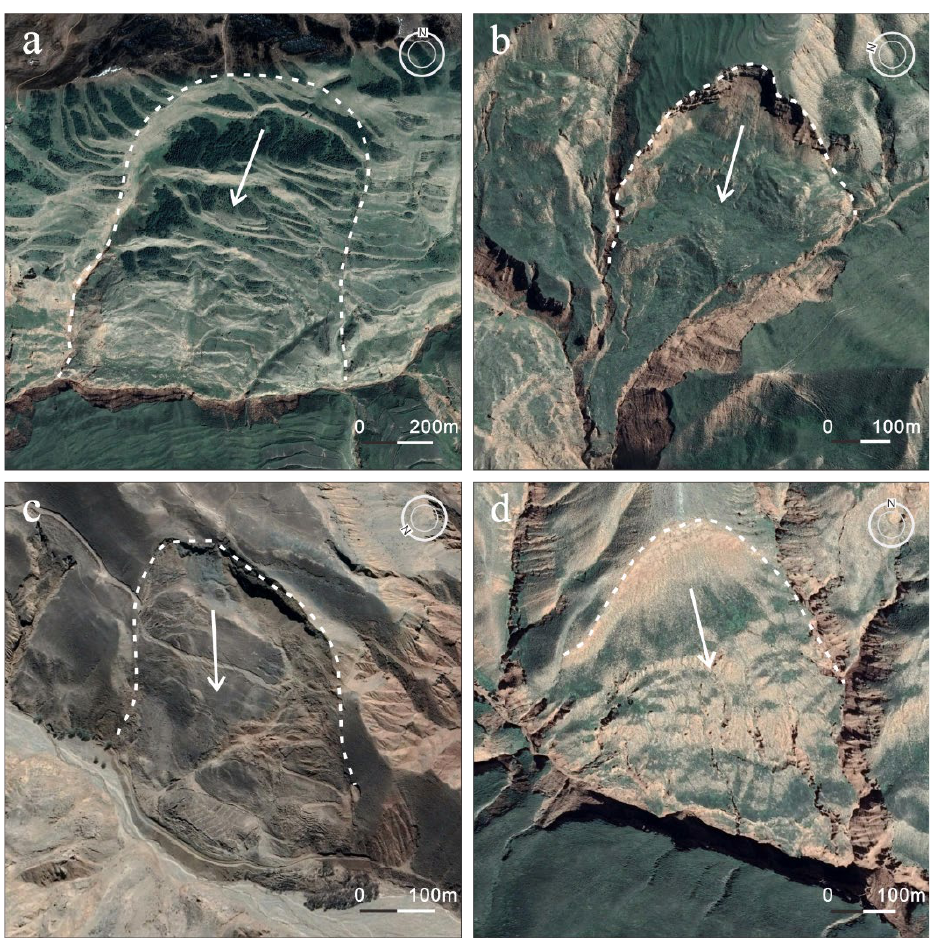
Figure 2. Typical landslide images on Google Earth. ( a ) at 35.98° N, 102.39° E, ( b ) at 35.972° N, 102.383° E, ( c ) at 36.018° N, 102.5° E, ( d ) at 35.96° N, 102.42° E. The white arrows represent the general direction of the landslides sliding. The white dashed line is the boundary of the landslides.